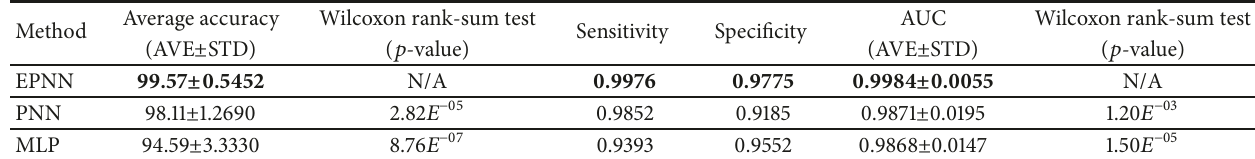
Table 8: Experimental results for Qualitative Bankruptcy data set.